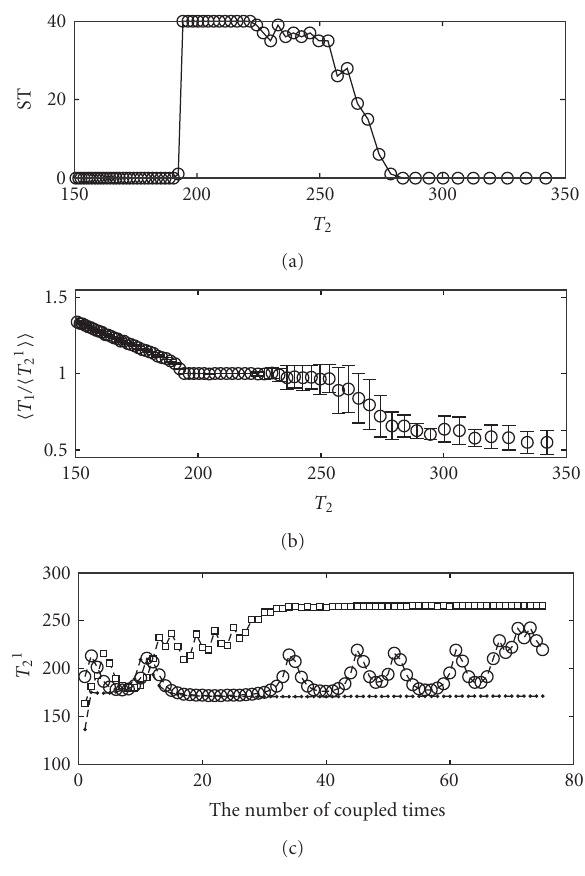
Figure 2: Synchronization results for dc-STDP rule carrying out 40 times. Figure 2(a) shows the number of synchronization times (ST) of fixed T 2 varying from 150 milliseconds to 320 milliseconds. Synchronization window is from 194 to 221. The probabilistic synchronization window is from 222 to 289. Figure 2(b) presents the quality of synchronization against the ratios of uncoupled periods. In Figure 2(c), we fix T 2 = 265 milliseconds which falls into the probabilistic synchronization window. There are three states of the coupled period of post-synaptic neuron T 21 when we carry out 40 stimulation times: (i) keeping the initial period (squares); (ii) oscillating (circles); (iii) synchronizing with the pre-synaptic neuron